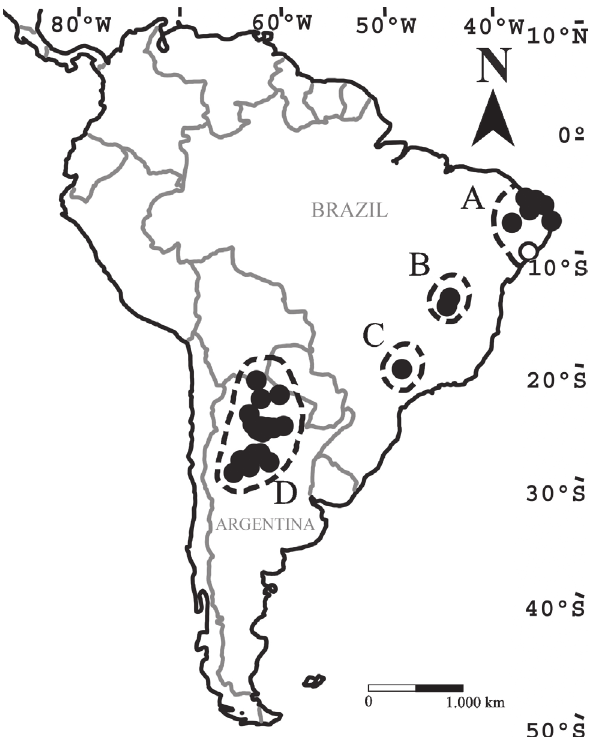
Figure 1. Distribution of the fairy shrimp Dendrocephalus brasiliensis Pesta, 1971. Full circles correspond to sites of occurrence. Empty circles correspond to the new record for the present study (Porto Real do Colégio, Alagoas state). A) Piauí, Ceará, Rio Grande do Norte and Paraíba states; B) Bahia and Minas Gerais states; C) São Paulo state; D) northern Argentina. References: Lemos-de-Castro and Lima (1986), César (1989), Rabet and Thiéry (1998), César et al . (2004), Mai et al . (2008), Chaves et al .